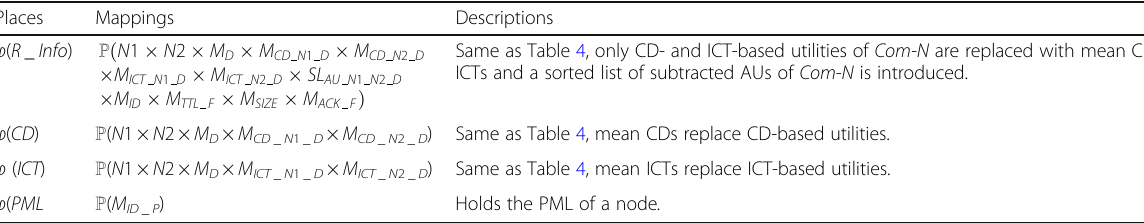
Table 8 Places and mappings of UBS